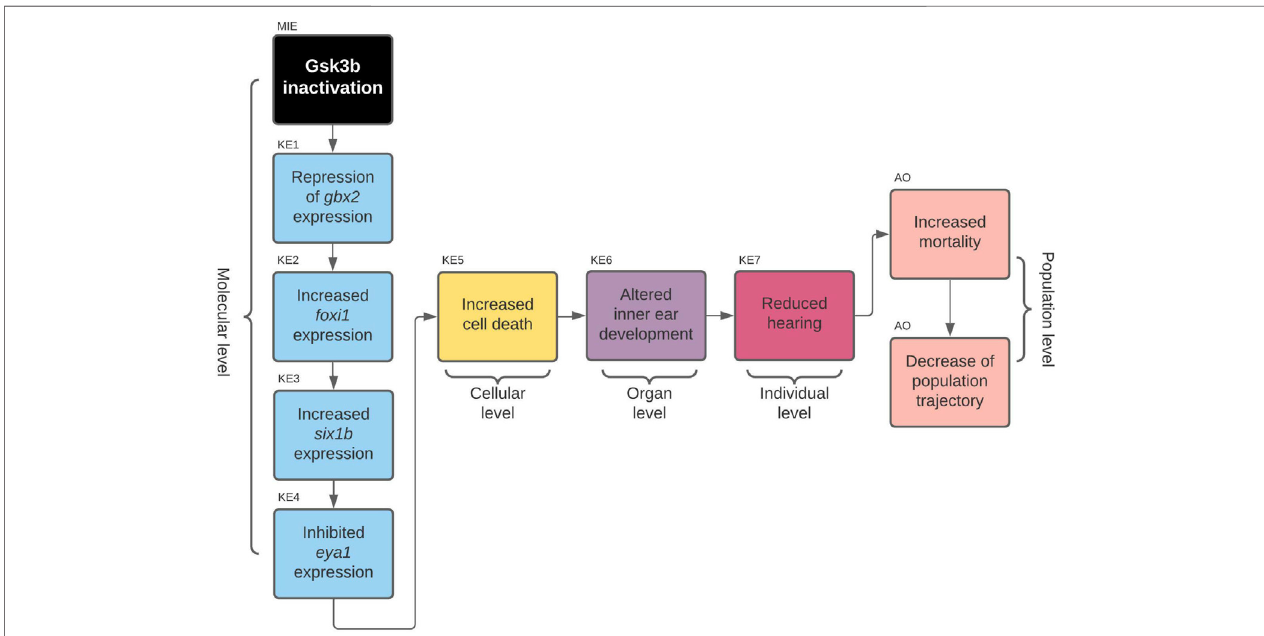
FIGURE 5 | AOP 410. Gsk3beta inactivation leads to increased mortality via defects in development of the inner ear.